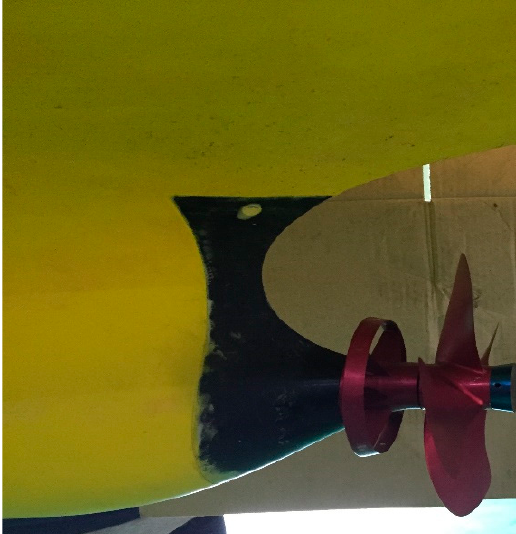
Figure 14. The model ship of 158K crude oil tanker.